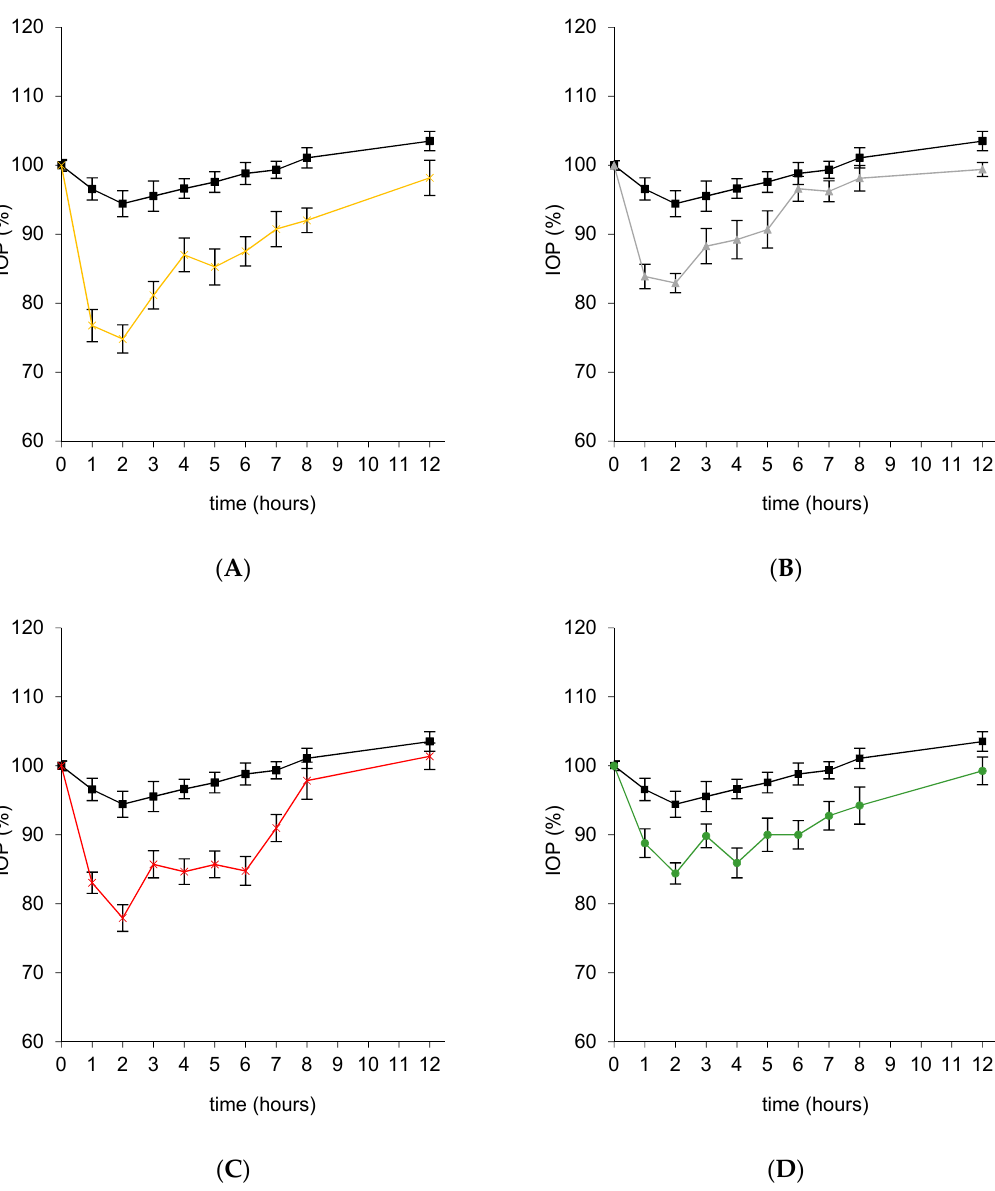
Figure 4. Intraocular pressure (IOP) reduction generated by a single instillation of the following formulations: ( A ) TM-GNP16 (TM 0.5%), ( B ) marketed formulation (TM 0.5%, used as a reference), ( C ) TMGNP8 (TM 0.25%) and ( D ) TMGNP3 (TM 0.1%). In black, IOP reduction curve of unloaded gelatin nanoparticles used as control.